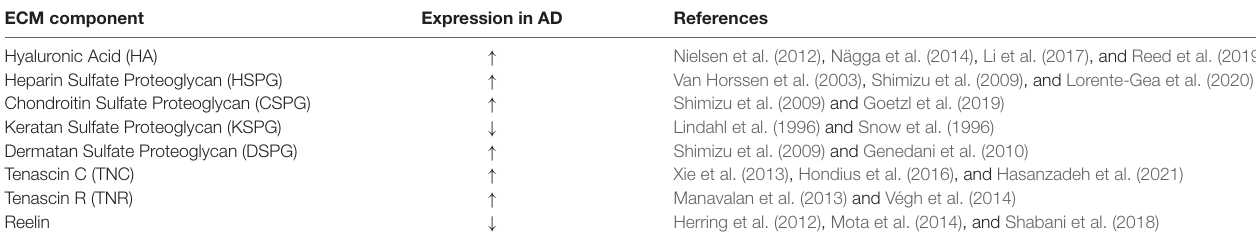
TABLE 1 | Expression of extracellular matrix (ECM) component changes in the pathological state of AD. ECM component